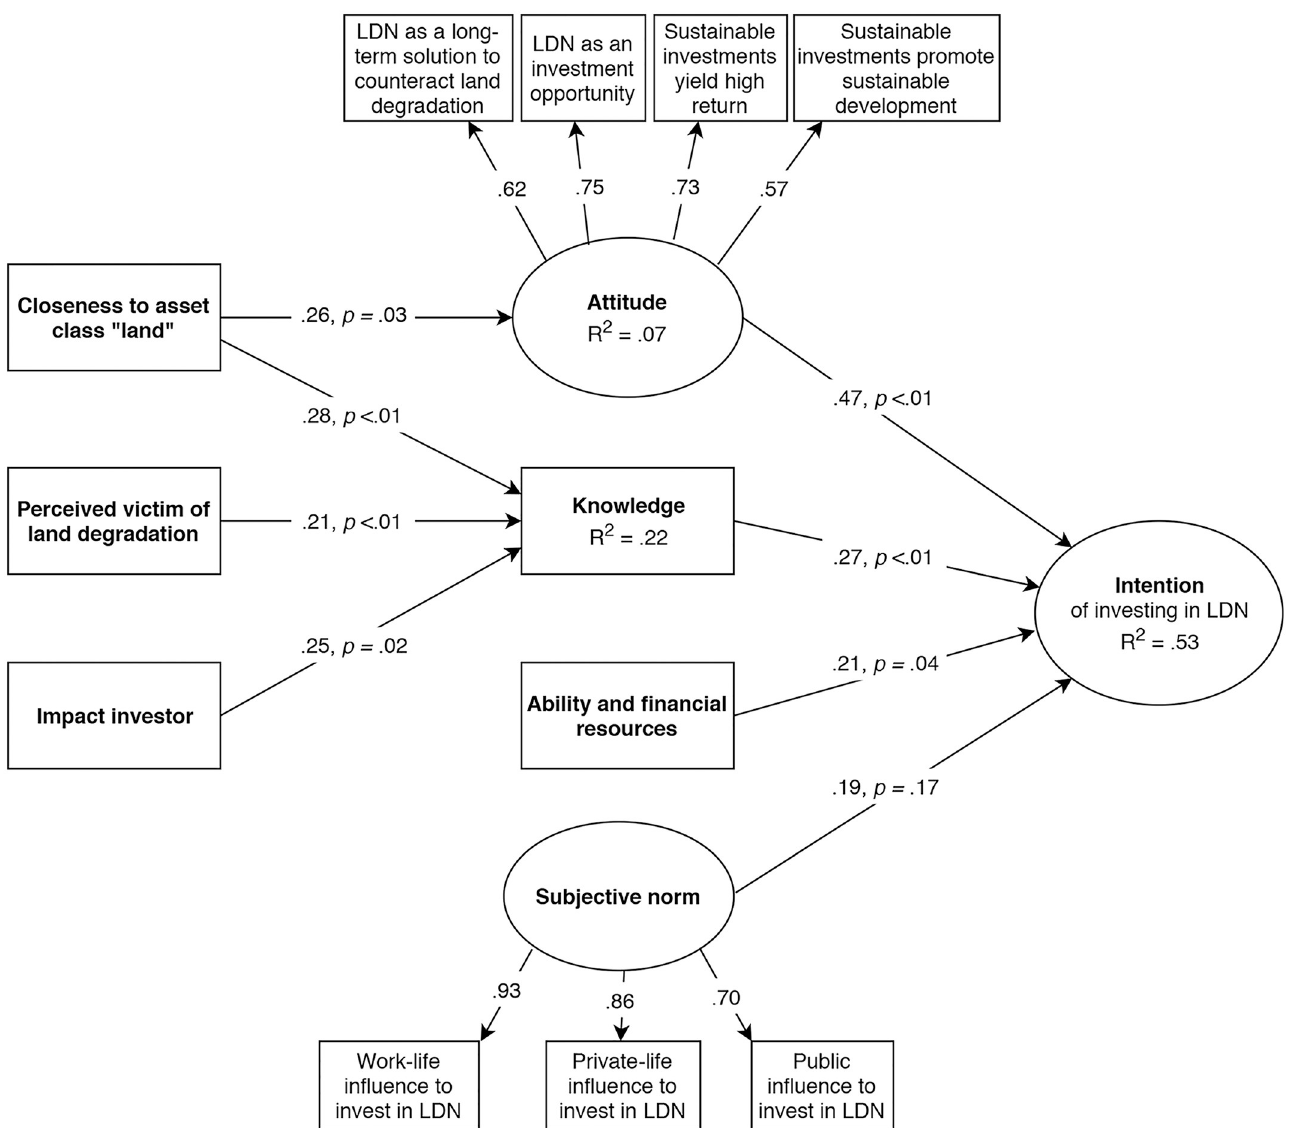
Fig 1. Structural equation model of how the intention to invest in LDN can be explained based on the theory of planned behavior, with standardised coefficients (betas) and p -values for all predictors of intention as well as standardised factor loadings of manifest variables on their corresponding latent variables (see Tables 1 and 2 for details). Round boxes represent latent constructs, consisting of multiple items, while square boxes are manifest constructs, captured by one single item.